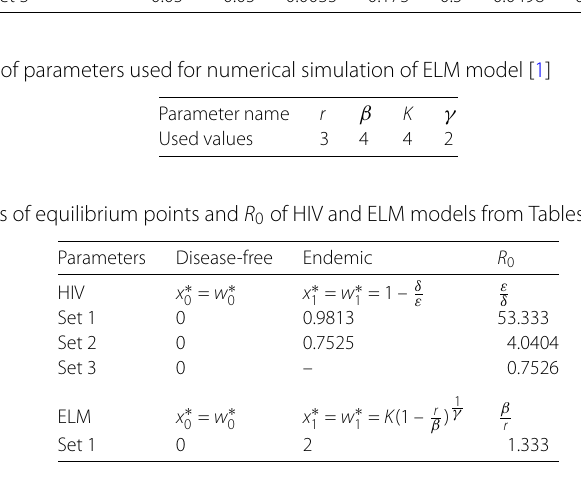
Table 9 Values of parameters used for numerical simulation of ELM model [1]